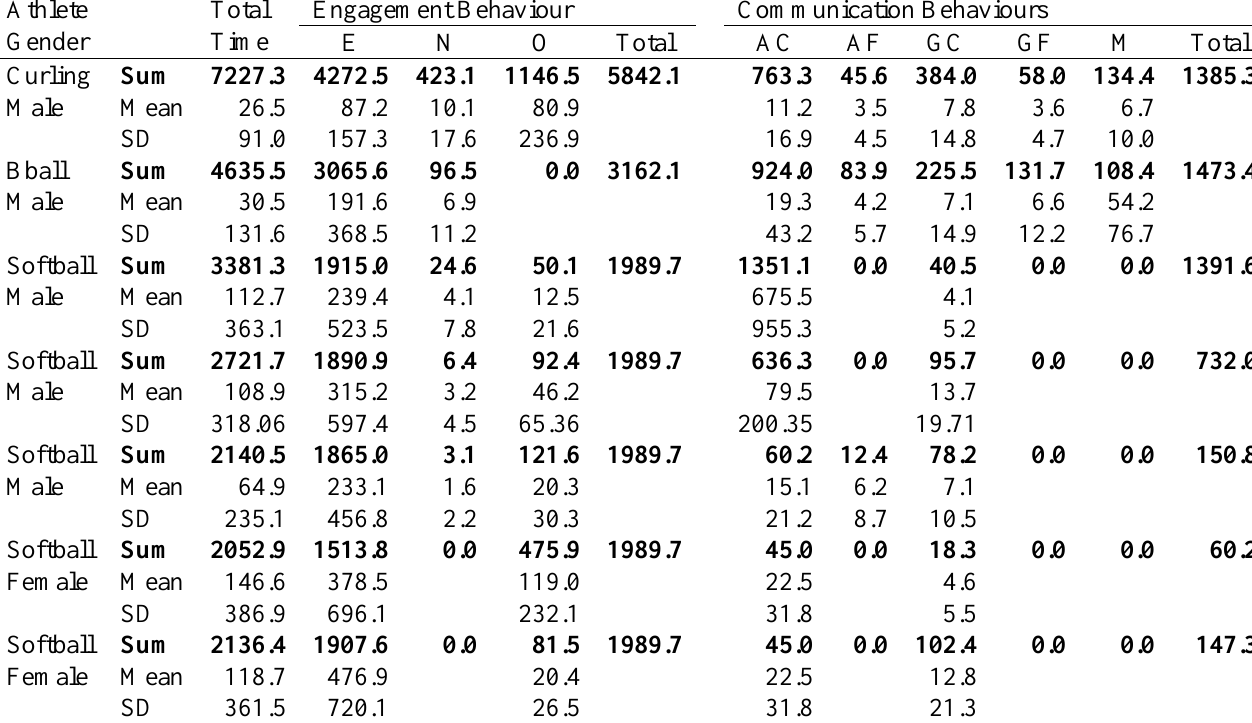
Table 3. Behaviour durations in seconds by